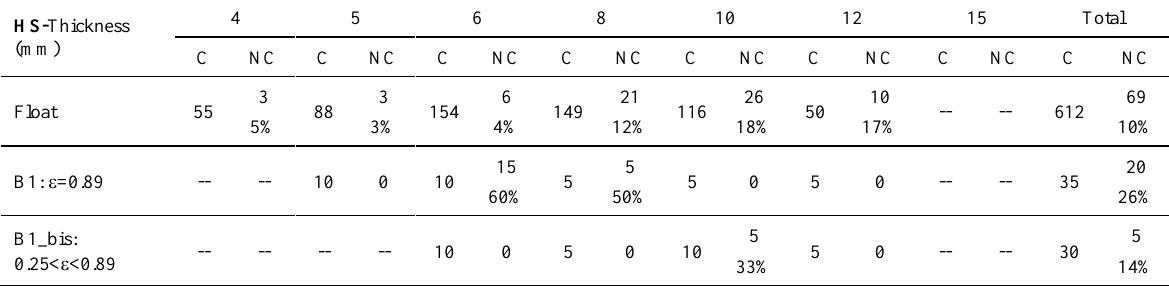
Table 3b: Number of HS tested for